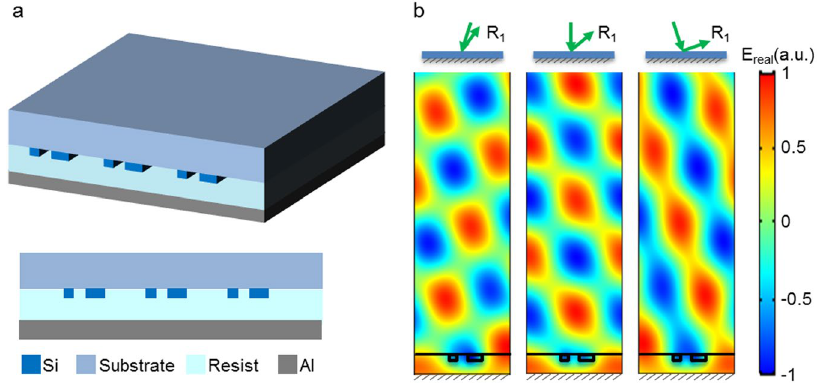
Figure 2. Design of reflection mode metasurfaces. ( a ) Metasurface schematic with a PMMA spacer layer between the nanobeams and the metal layer. The nanobeams have a thickness of 25 nm and widths of 30 nm and 60 nm respectively, with an edge-to-edge gap of 45 nm and periodicity of 380 nm. ( b ) Simulated total out-of- plane scattered electric field at a wavelength of 520 nm at incidence angles of − 18, 0 and 18 degrees. The insets above the electric field maps show the schematic diagram of the + 1 order of diffraction from the reflection mode metasurface. The green arrows indicate the wave vectors of the incident light and the + 1 reflected order of